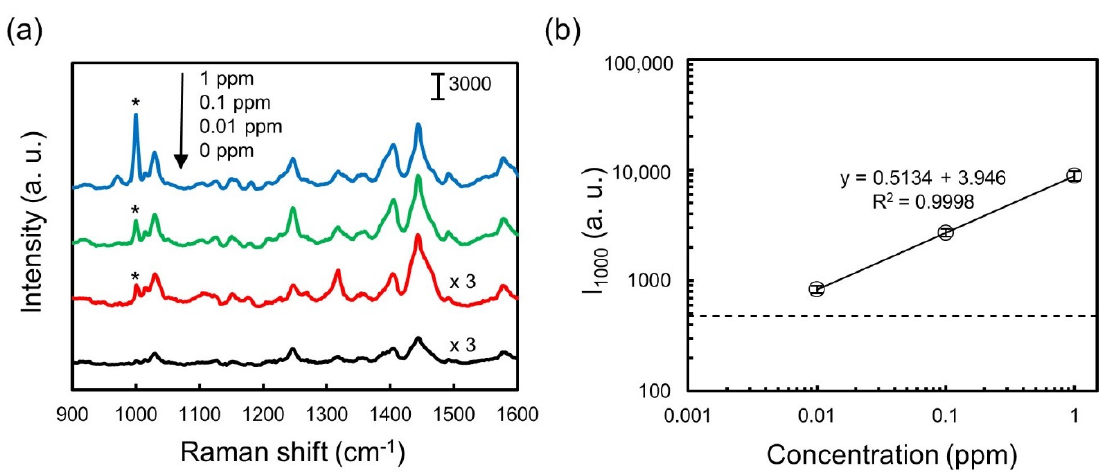
Figure 6. SERS detection of MC in water after sample pretreatment. ( a ) SERS spectra of MC in water measured after sample pretreatment. The characteristic Raman peak of MC at 1000 cm − 1 is marked with “*”. ( b ) A plot of the intensity of the 1000 cm − 1 peak versus MC concentration. Error bars show standard deviations with n = 30. The straight line is the linear regression line, and the dotted line indicates mean plus 3 σ of the 1000 cm − 1 peak of the blank sample.